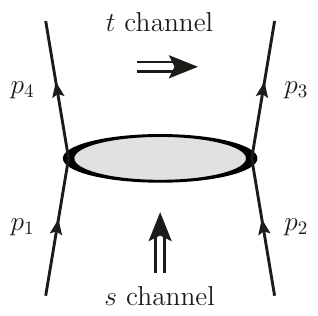
t > 0. The (cid:12)gure also (cid:29) (cid:0)